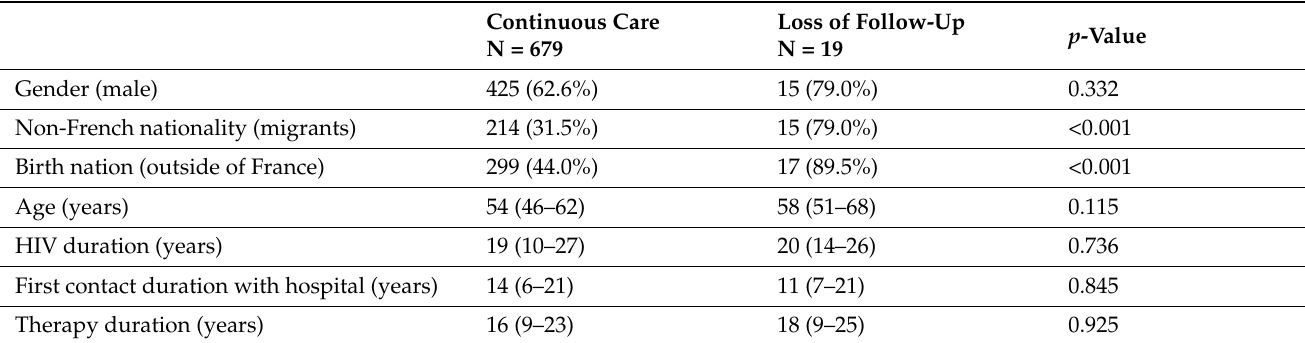
Table 1. Characteristics of patients with continuous care compared to patients lost to follow-up (i.e., at least one year during the COVID-19 pandemic).